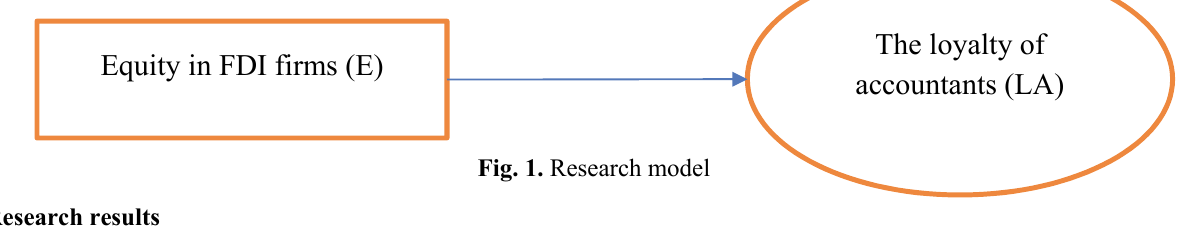
Fig. 1. Research model